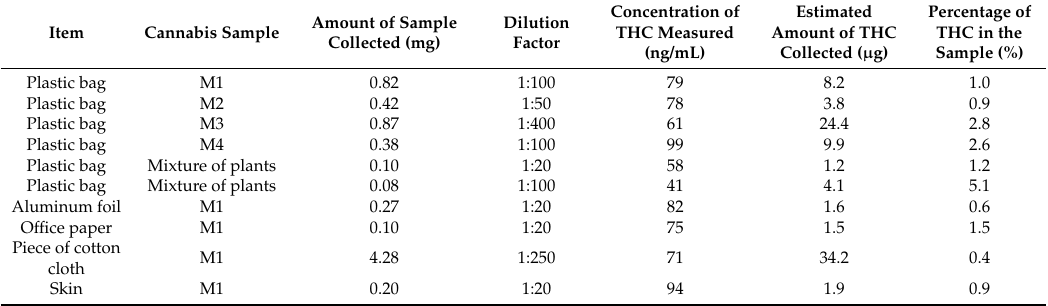
Table 3. Mean concentrations of THC found in the analysis with residues of THC ( n = 3), and their equivalence in amount of THC collected and percentage of THC in the samples.